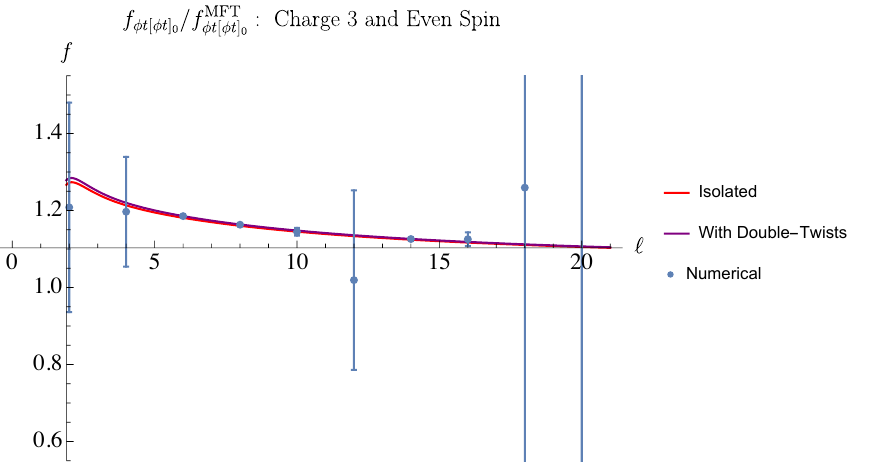
Figure 27 . The e(cid:11)ects of DTIs for OPEs of leading double twists in the charge 3 [ (cid:30)t ] 3